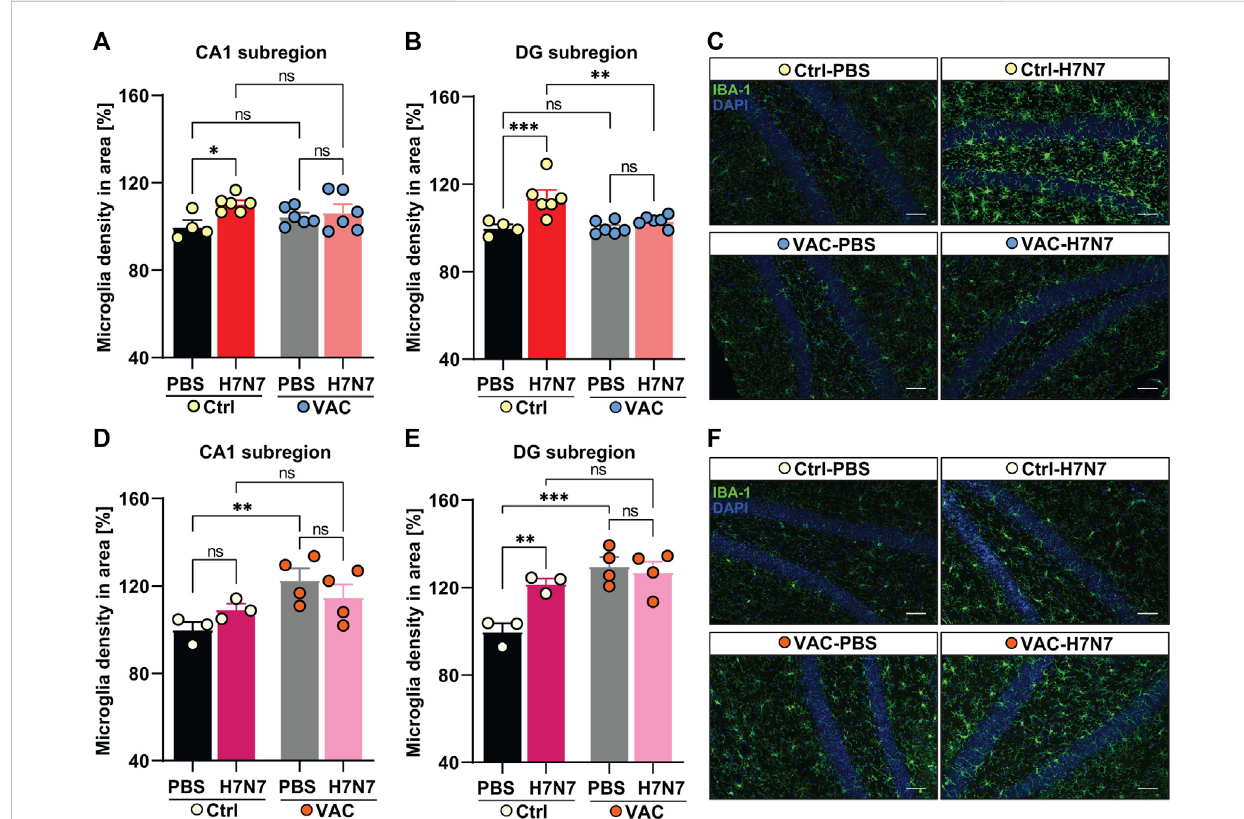
FIGURE 4 Effectsofvaccinationonhippocampalneuroin fl ammationinducedbyH7N7IAVinfection. Inyoungmice (A) microglialdensityintheCA1subregion of the hippocampus was signi fi cantly increased 8 days after H7N7 IAV infection in unvaccinated mice compared with the corresponding control. In vaccinated mice, this increase was not present after H7N7 IAV infection. Vaccination itself did not result in the signi fi cant increase in microglial density in CA1( n =4 – 6animalspergroup). (B) InfectionwiththeH7N7IAVresultedinasigni fi cantincreaseinmicroglialdensityinthedentategyrussubregion in unvaccinated mice compared with the control group. This increase was not seen after H7N7 IAV infection in previously vaccinated mice.